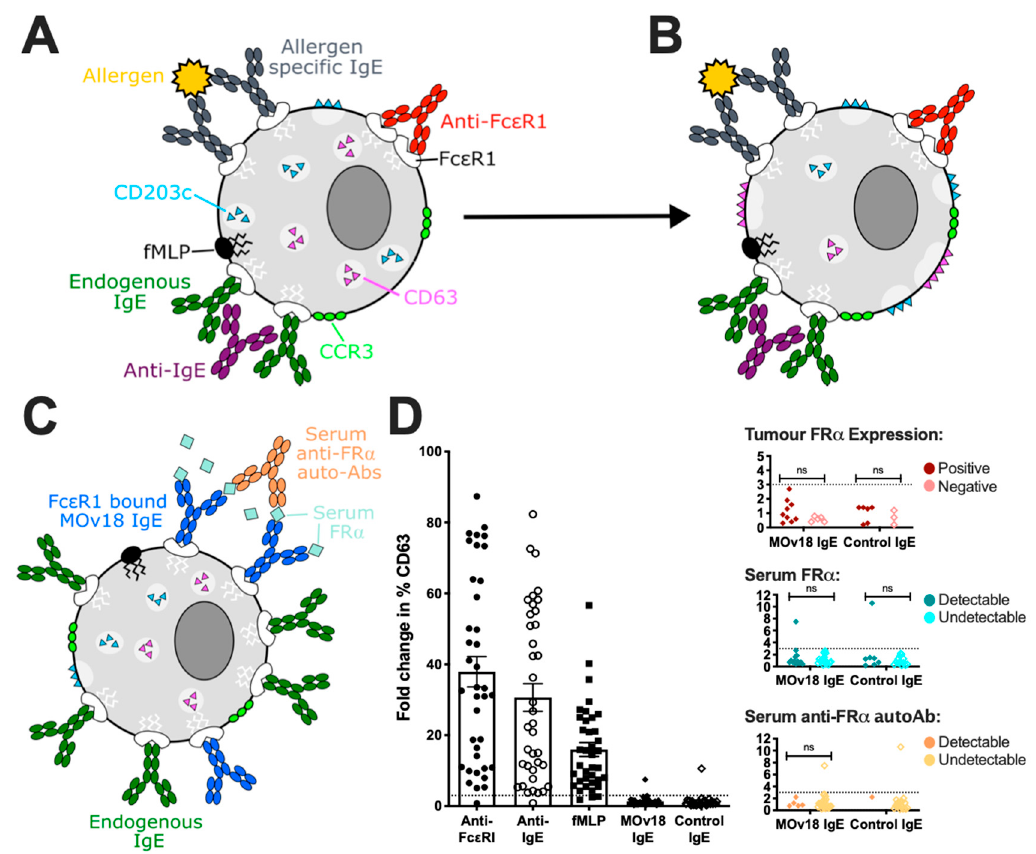
Figure 5. Basophil activation test (BAT). ( A ) Basophils can be identified in unfractionated whole blood samples by cell surface markers, such as CCR3 and CD203c. ( B ) Surface expression of CD63 and CD203c is upregulated in activated basophils through the fusion of intracellular vesicles, via both IgE- (anti-Fc ε RI, anti-IgE and allergen cross-linking of specifc IgE) and non-IgE-mediated (fMLP) stimuli. Adapted from Bax et al. [11]. ( C ) Circulating FR α anti-FR α autoantibodies found in ovarian cancer patient sera may form immune complexes with MOv18 IgE triggering basophil activation. ( D ) Ex vivo basophil activation ( > 3.0 fold change in % CD63 expression) was measured following incubation with anti-Fc ε R1, anti-IgE, fMLP stimulation, but not triggered by MOv18 and control IgE antibodies, in all but one patient. Activation by MOv18 IgE, or lack thereof, was irrespective of patient tumour FR α expression, or the presence of FR α and anti-FR α autoantibodies in patient sera. Adapted from Bax et al. [79].